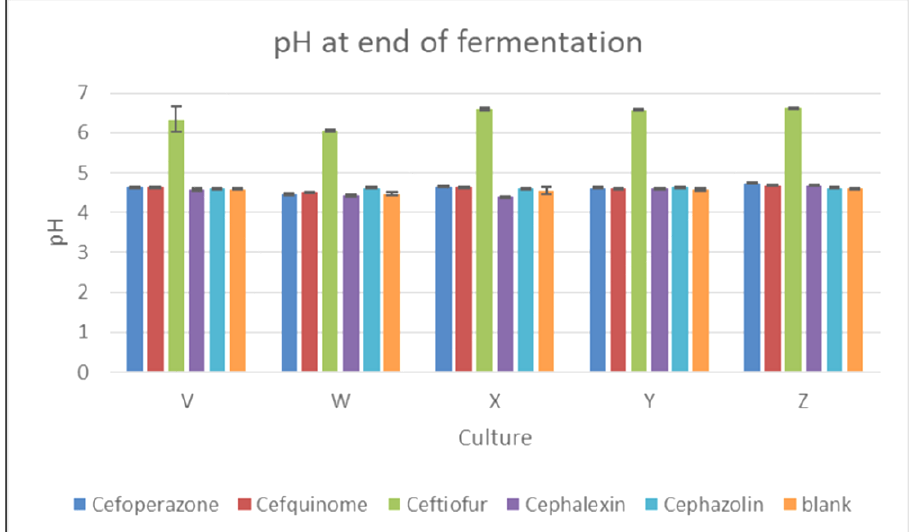
Figure 2. The effect of five cephalosporin antibiotics (cephalexin, cefoperazone, cefquinome, cefazolin, and ceftiofur) on the activity of five yoghurt cultures (V, W, X, Y, and Z) in relation to the pH value at the end of fermentation.